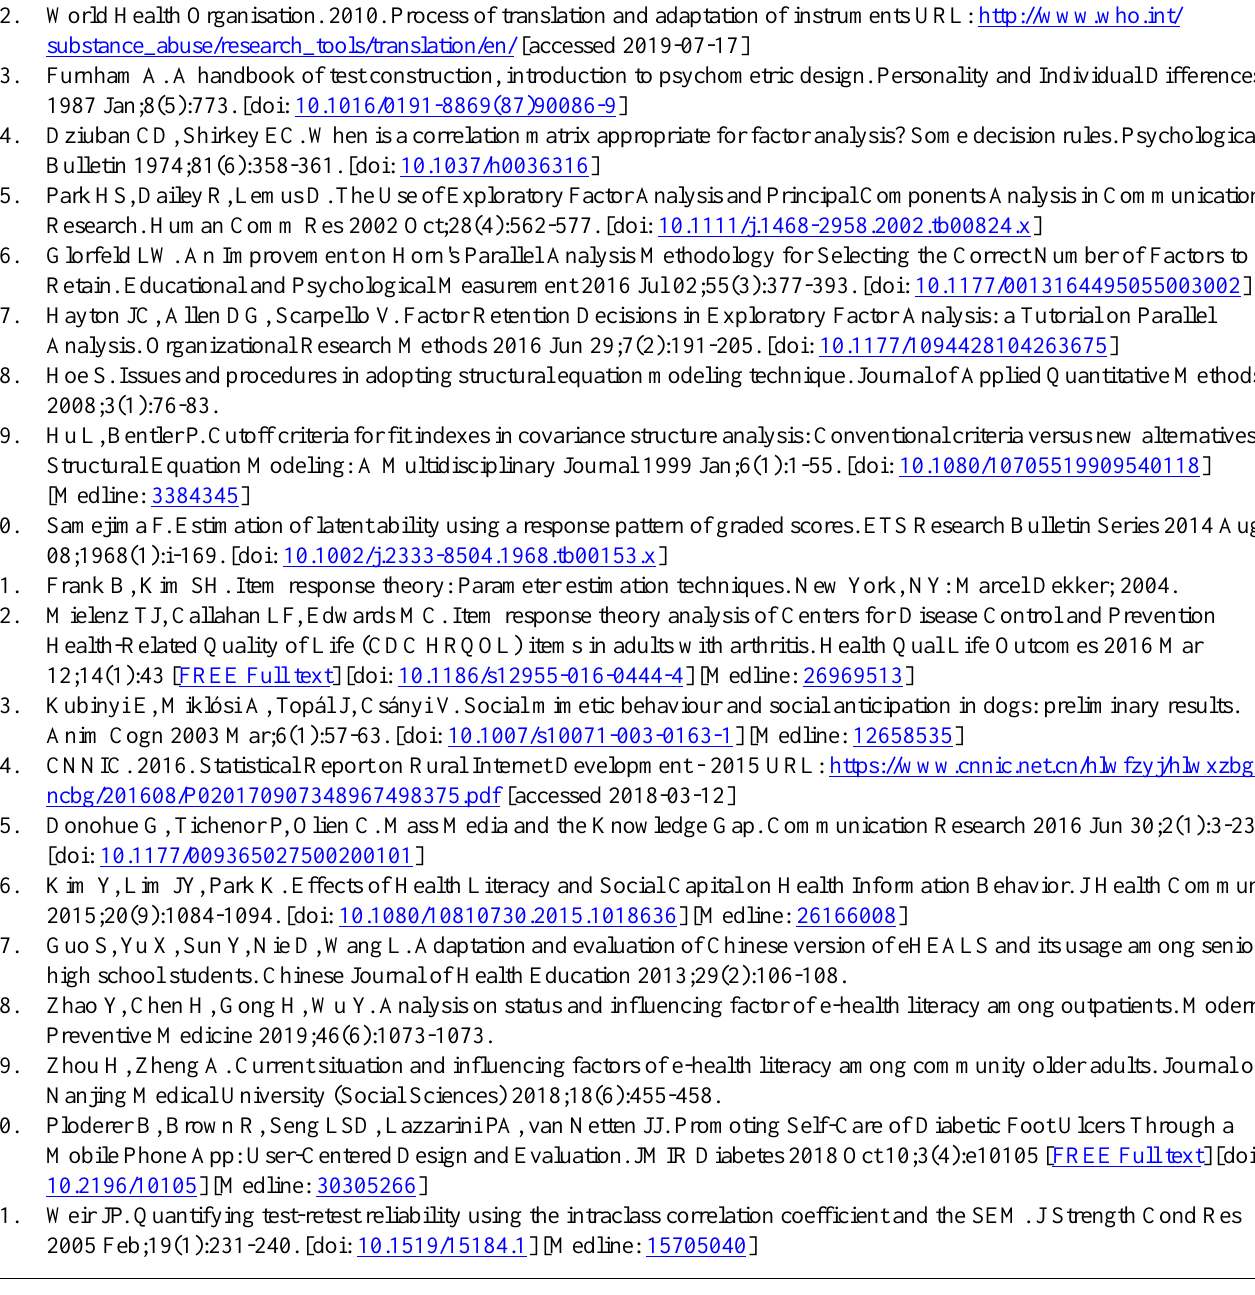
C-eHEALS: simplified Chinese version of the eHealth Literacy